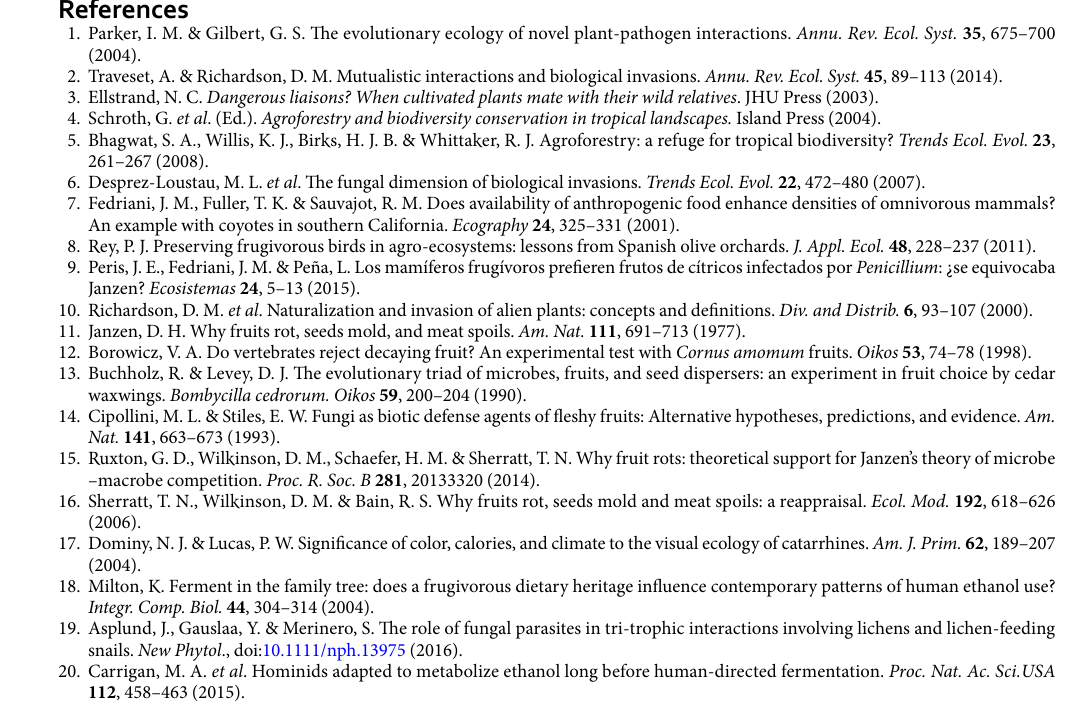
Statistical analyses. The results were analysed by fitting generalized linear mixed models using the Proc Glimmix from SAS 51 , which allows the modelling of non-normal response variables as well as the usage of both fixed and random factors 52 . We first evaluated overall frugivore preference for infested vs . intact fruits. In this model, the percentage of fruit harvesting was the response variable, whereas fruit infestation and region (tropi- cal, Mediterranean) were specified as fixed factors. Then, we evaluated guild-specific fruit preferences by fitting a second model with frugivore guild (seed dispersers, seed predators, and pulp consumers) and fruit infestation (infested vs . intact fruits) as fixed factors. To evaluate the consistence of the effect of one factor at the different levels of other factors, in both models we also included second-order interactions among main effects. When the interaction between any two factors was significant, tests for the effect of a given factor at the different levels of the other factor (i.e. tests of slices) were performed using the SLICE option in the LSMEANS statement of the MIXED procedure 51 . Season (2013, 2014, and 2015) and block (nested within parcel) were included as random factors in both models. To compare the effects of different levels of any significant main factor, we calculated the difference between their least-square means. Because of the binomial nature of the response variables (percentage of fruit harvested), binomial error and logit link function were specified. Identified VOCs emitted by orange fruits were classified into one of five main groups (ethers, alcohols, ketones, monoterpenes hydrocarbons, and esters). Multivariate analysis of variance (MANOVA) in GLM pro- cedure 51, 52 were done to test overall differences in the percentages of the five main types of VOCs between Penicillium -infested and intact orange fruits. Once overall significant differences were detected, we applied uni- variate analyses for each group of VOCs. Differences in toughness, pH, and Brix degrees were also tested with multivariate and univariate analyses.